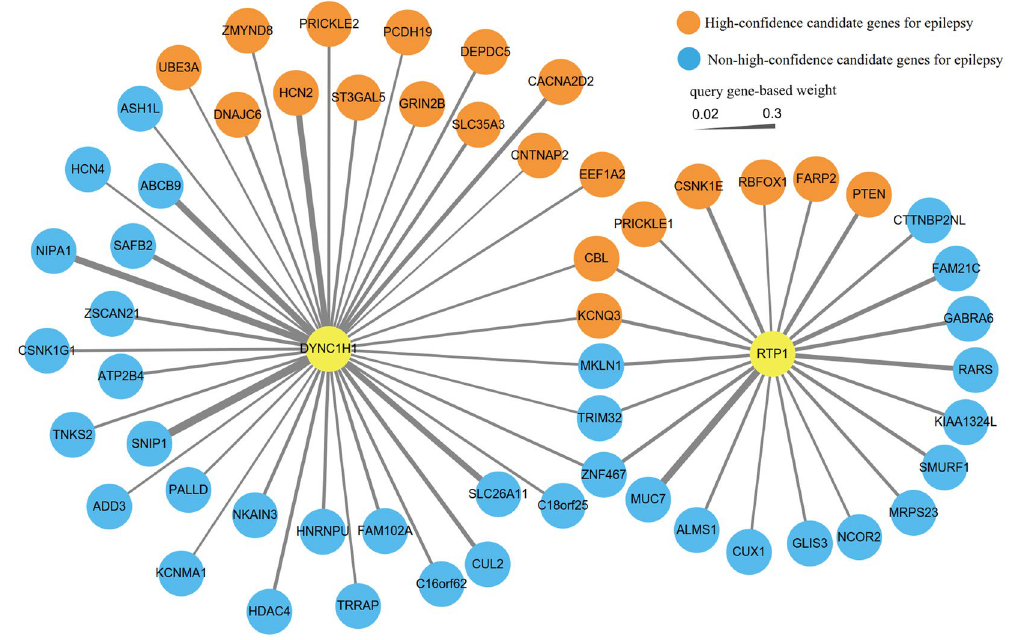
Figure 4. Genetic interaction network analysis of DYNC1H1 and RTP1 . A node represents genes, and an edge represents interactions between each pair of genes. Candidate epilepsy genes were extracted from the EpilepsyGene database.